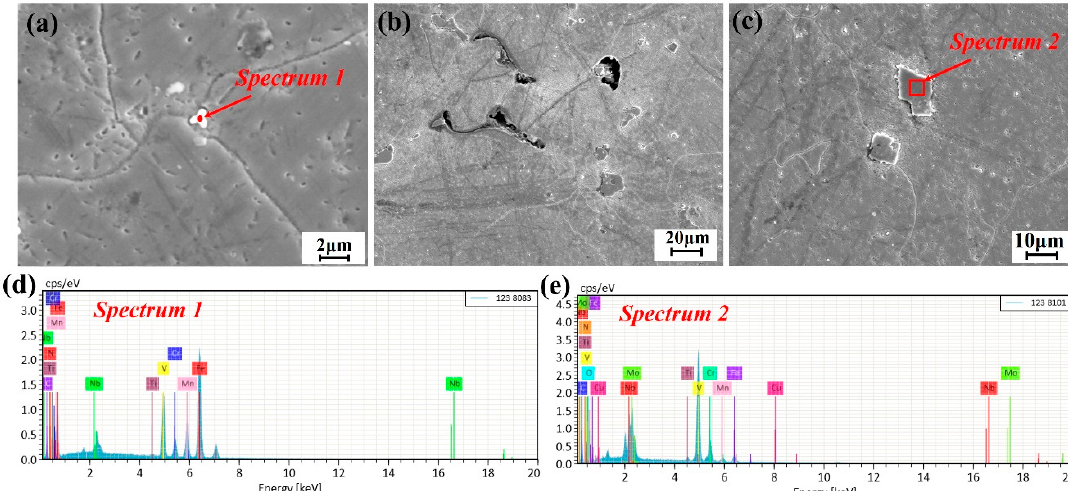
Figure 8. Scanning electron microscope (SEM) microstructure ( a – c ) of cast high-manganese steel and energy spectrum analysis ( d , e ) of precipitates in cast high-manganese steel.